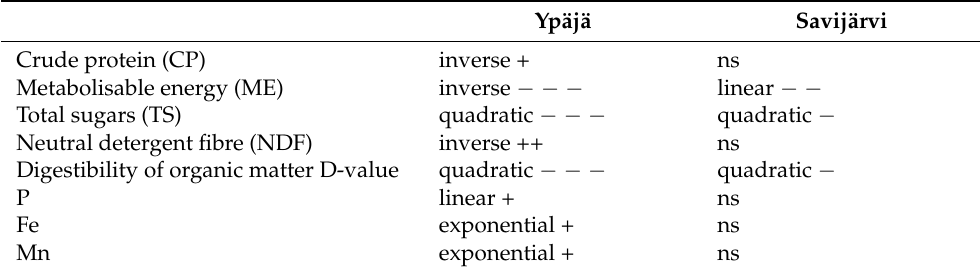
Table 3. Temporal changes in feed values and nutrient composition in Ypäjä semi-natural (08.06–24.09.2012, n = 22) and Savijärvi permanent pastures (08.06–31.07.2012, n = 24). The best fitting function as derived from the curve estimation procedure with negative ( − ) or positive (+) direction and statistical significance indicated by the number of